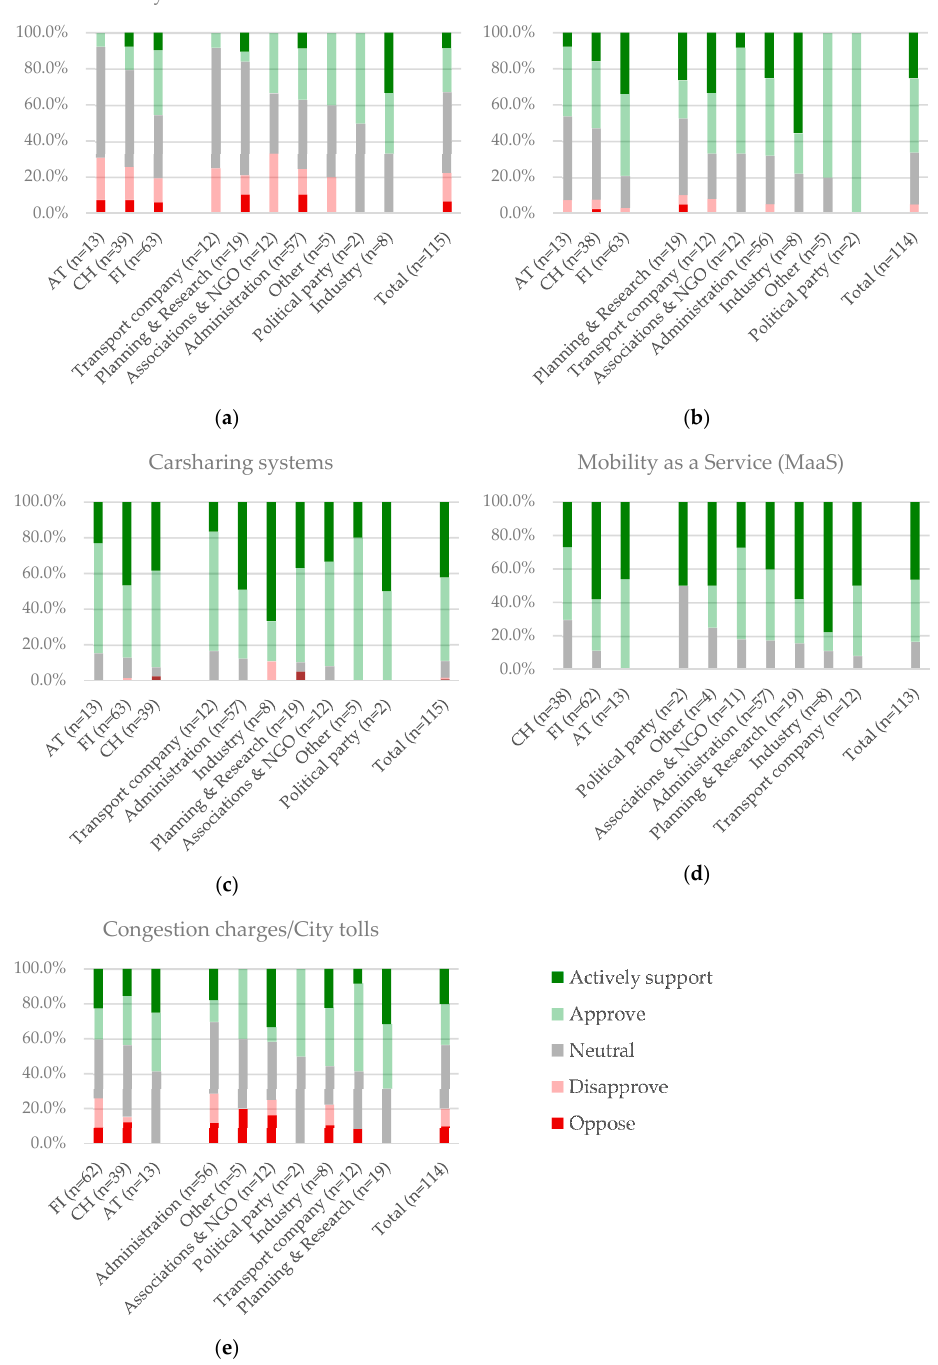
Figure 2. Openness of stakeholders regarding technological innovations ( a – e ). Data: ZHAW, Aalto University, tbw